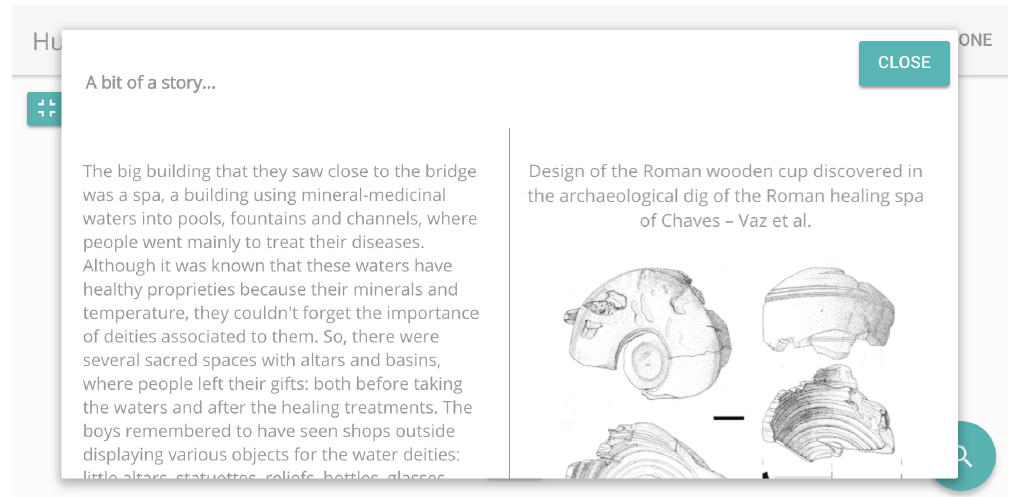
Figure 4. A bit of a story and visual contents linked to a reflective